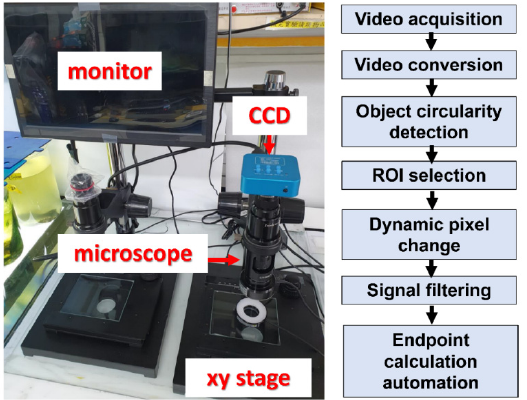
Figure A1. Microscopic instrument setup and major analysis pipeline for large-scale tail coiling in zebrafish embryos.